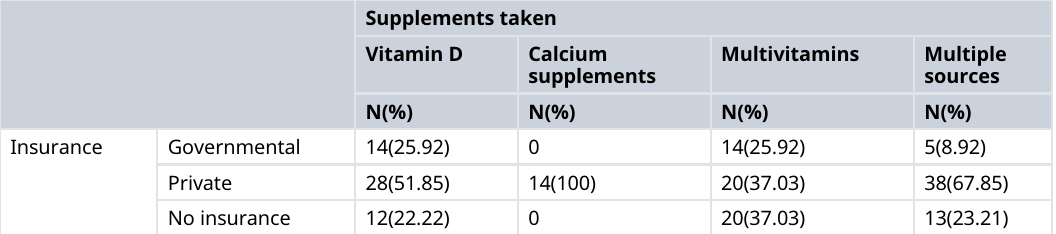
Table 5. Health insurance status of study participants and vitamin D supplementation